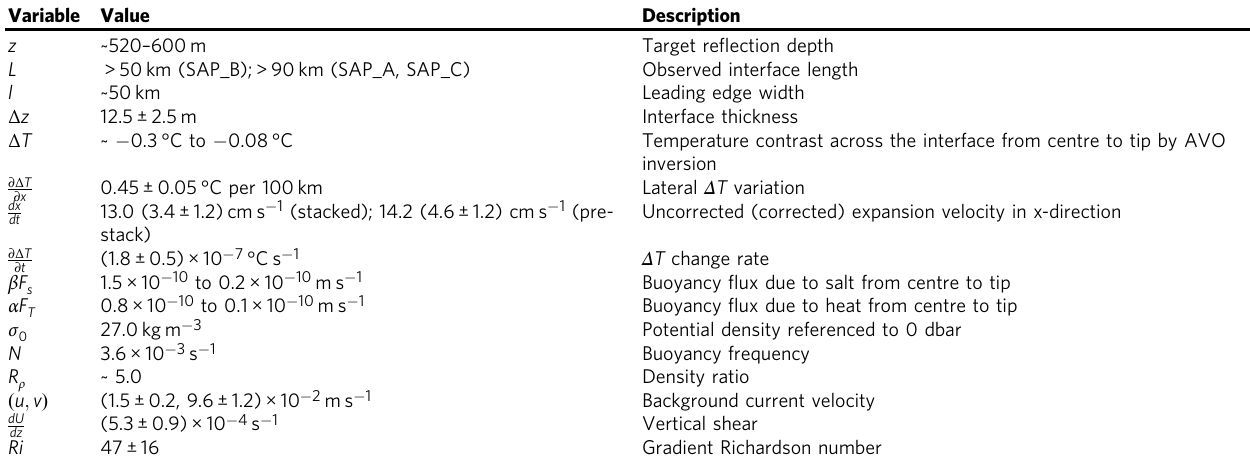
Table 1 Primary values and results from seismic and hydrographic measurements of the time-lapse interface Variable Value